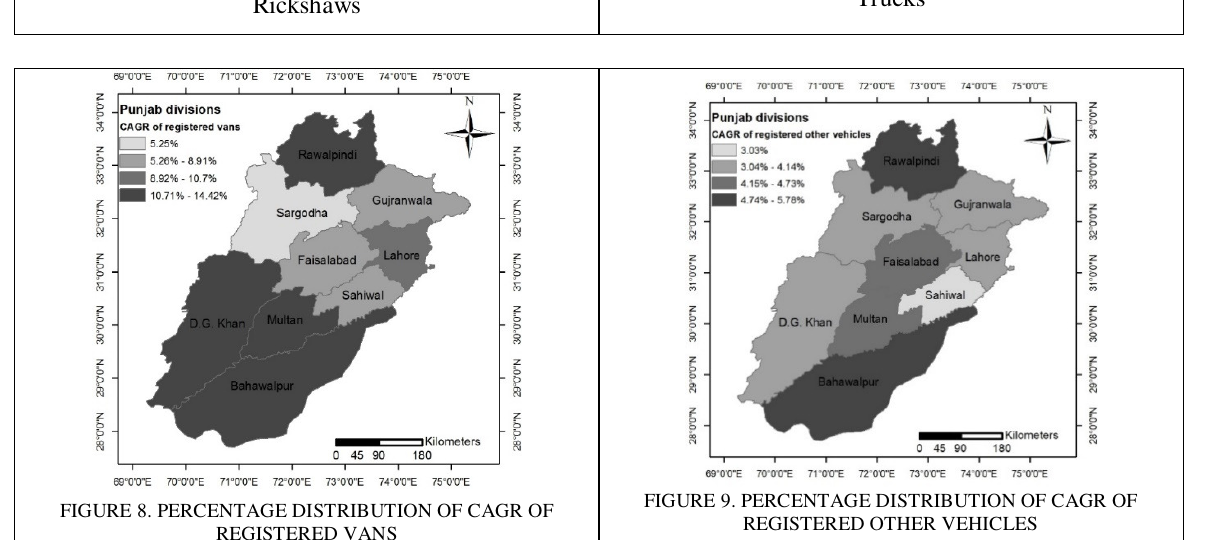
FIGURE 8. PERCENTAGE DISTRIBUTION OF CAGR OF REGISTERED VANS